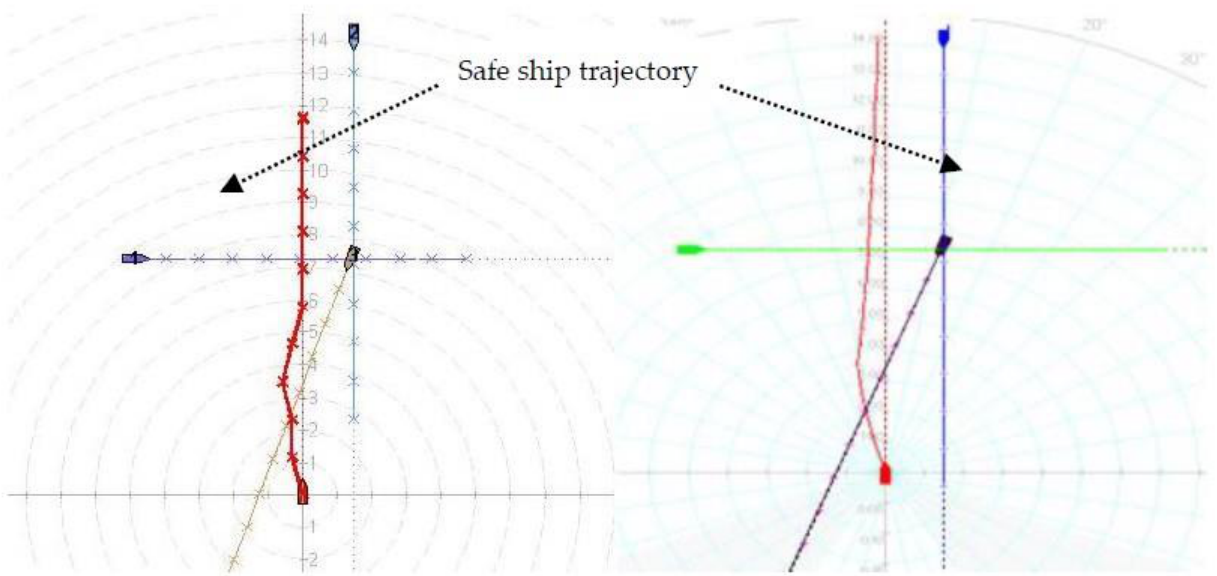
Figure 8. Safe ship trajectory when passing with three moving targets in restricted visibility. ( a ) ACNN; ( b ) ACEA.